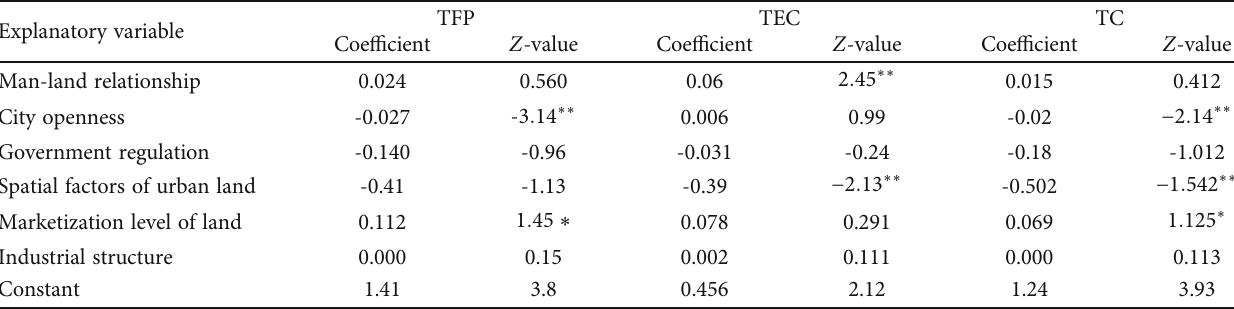
Table 5: Tobit regression analysis